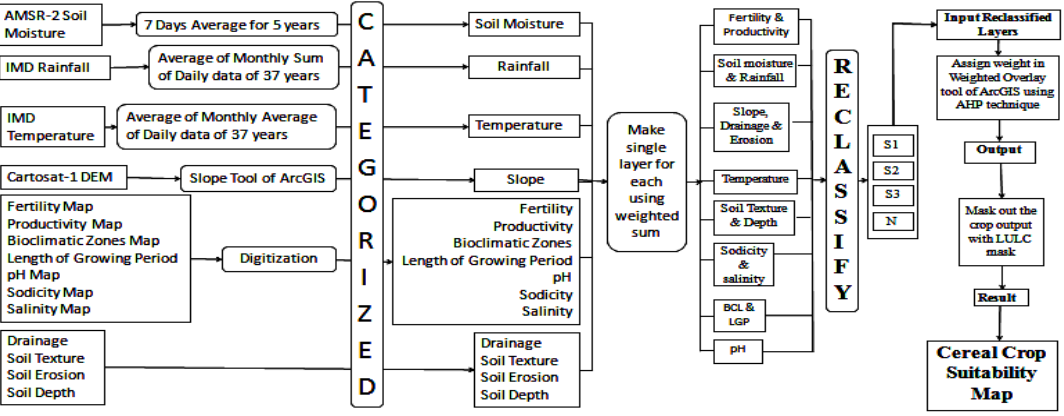
Figure 3. Methodology flow-chart